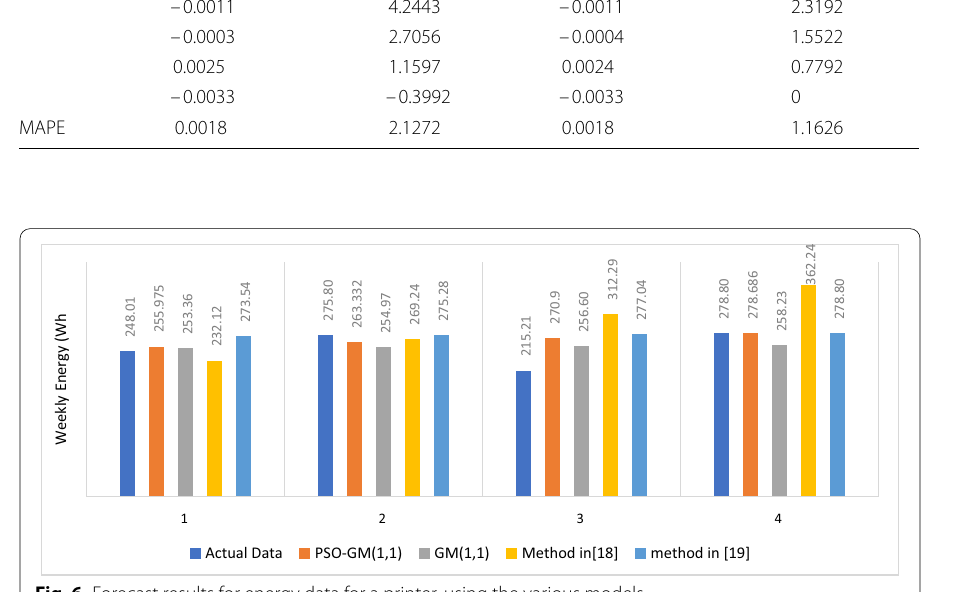
Fig. 6 Forecast results for energy data for a printer, using the various